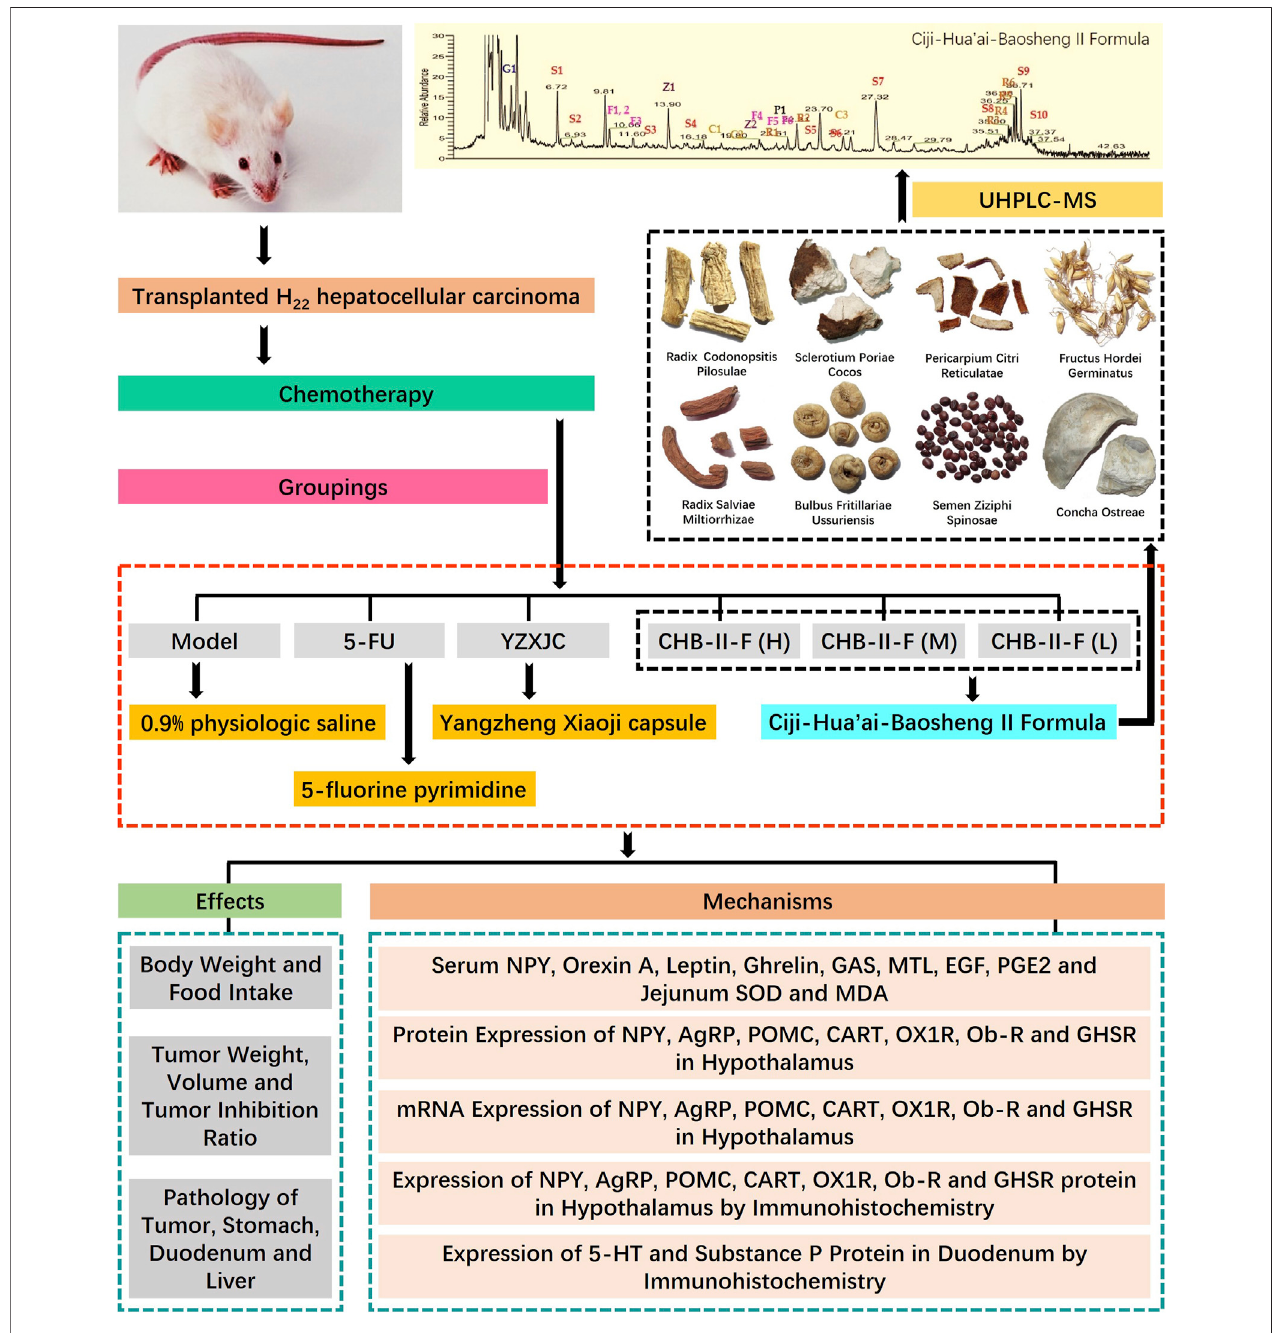
FIGURE 9 | Research conducted in this study. This study was divided into three main parts: identi fi cation of chief components in CHB-II-F using UHPLC-MS; veri fi cation of the therapeutic effects of CHB-II-F in chemotherapy-treated mice; and exploration of the mechanism underlying CHB-II-F using ELISA, western blot, RTFQ-PCR, and IHC to detect appetite-related